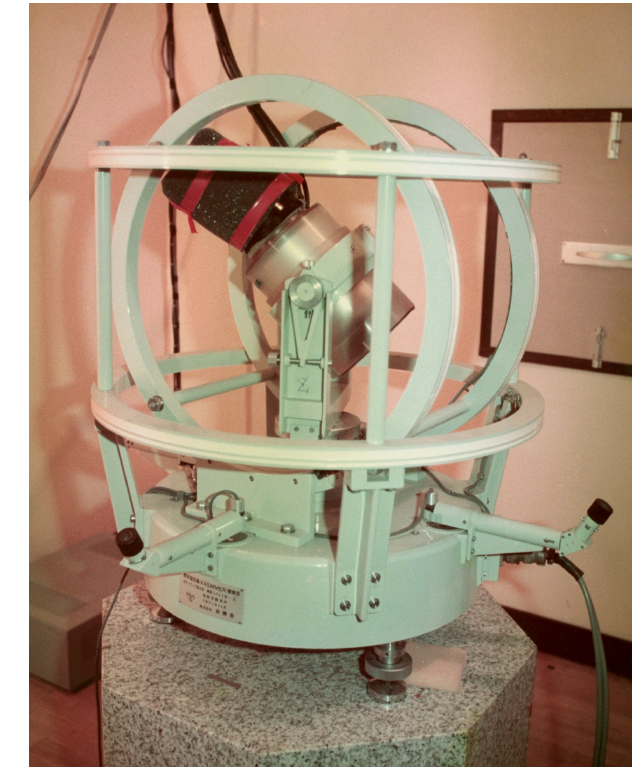
Figure 25. Optical pumping magnetometer with a set of Helmholtz coils surrounding it (photo supplied by Kakioka Magnetic Observa- tory).